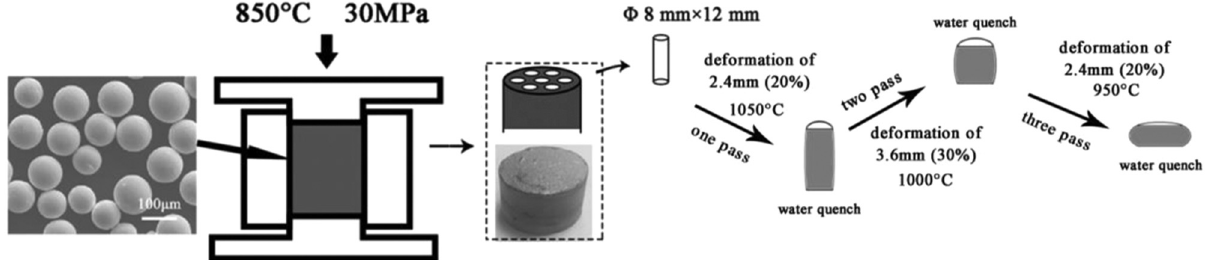
Figure 1: Diagram of the